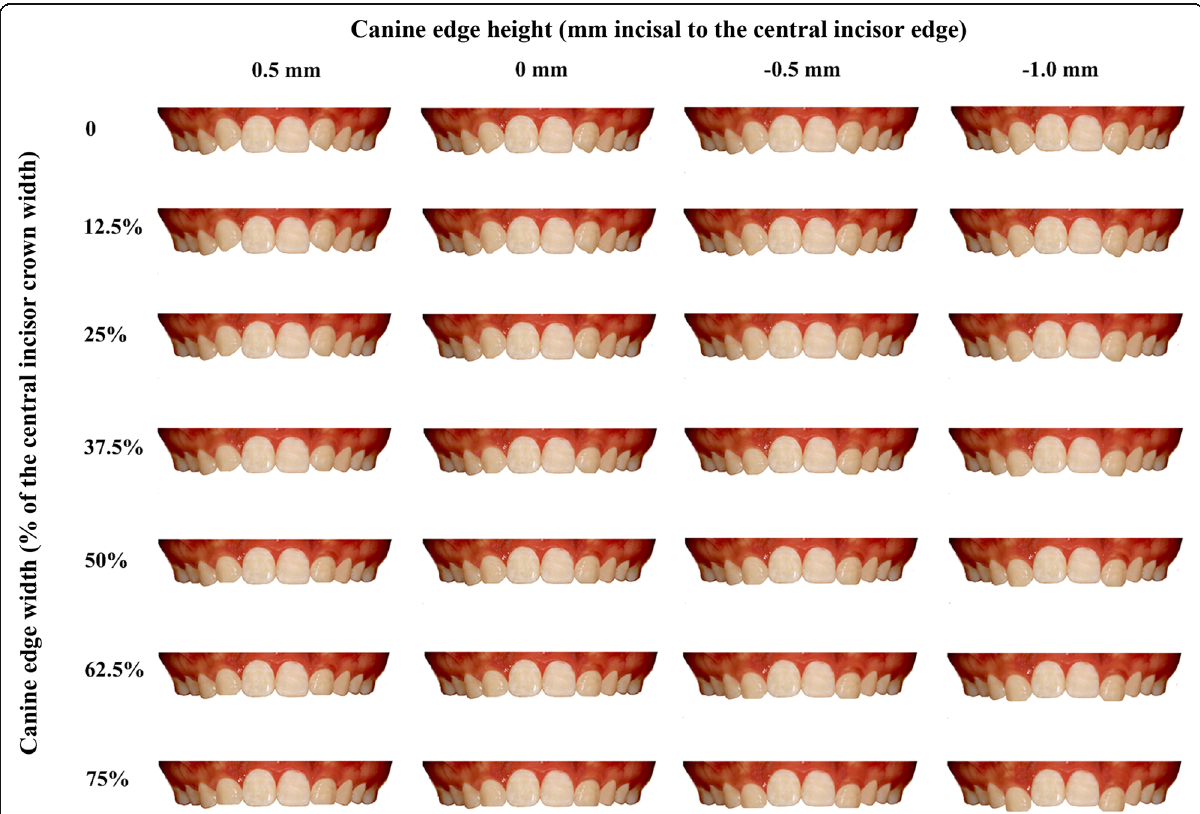
Fig. 2 Example of the images used in the study. The canine edge width was based on the percentage of the incisal width of the maxillary central incisor and categorized to 0%, 12.5%, 25%, 37.5%, 50%, 62.5%, and 75% of the central incisor width. The canine edge height was defined as the distance of the incisal edges between the maxillary canine and central incisor, and categorized to − 0.5 mm, 0 mm, 0.5 mm, and 1.0